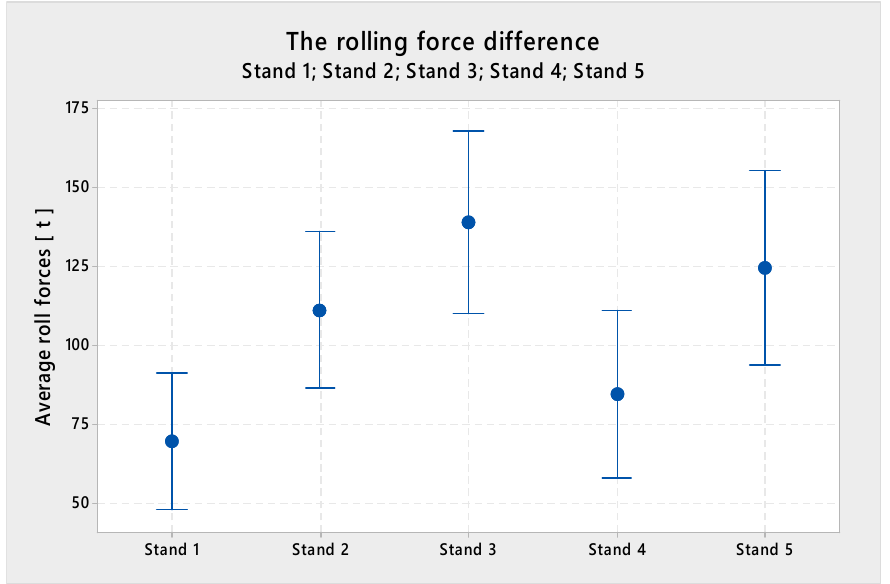
Figure 12. Difference of forces slow and fast rolling. Figure 12. Di ff erence of forces slow and fast